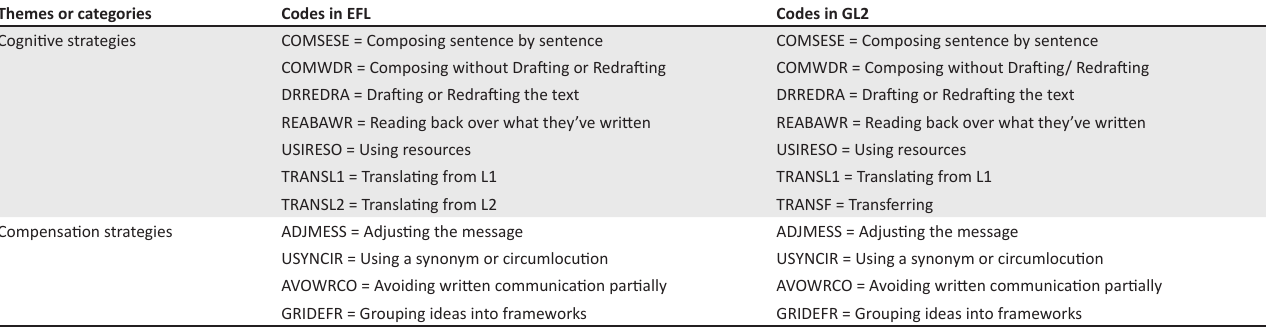
TABLE 2: Categories and codes of the thematic strand ‘whilst-writing stage’. Themes or